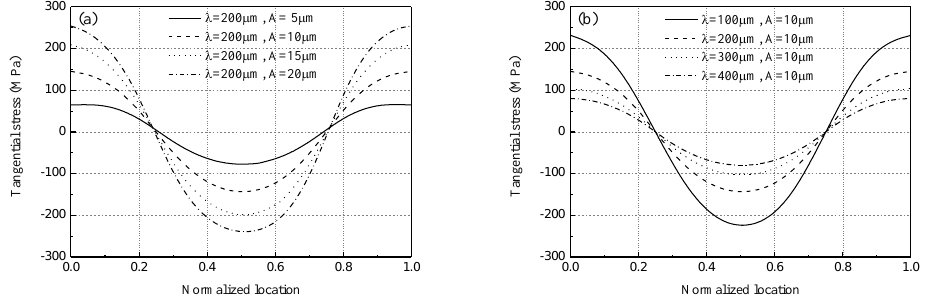
Figure 7. Variations of tangential thermal residual stress along the EBC/BC interface of CMCs coatings with different ( a ) amplitude; ( b ) wavelength.